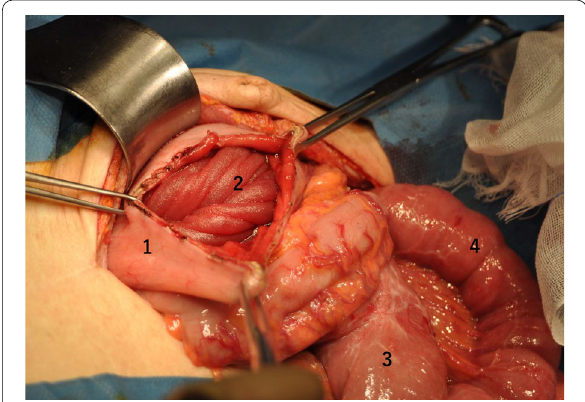
Fig. 3 Intraoperative findings revealed jejunogastric intussusception. (1) Incised remnant stomach, (2) intussuscepted jejunum, (3) afferent loop, (4) efferent